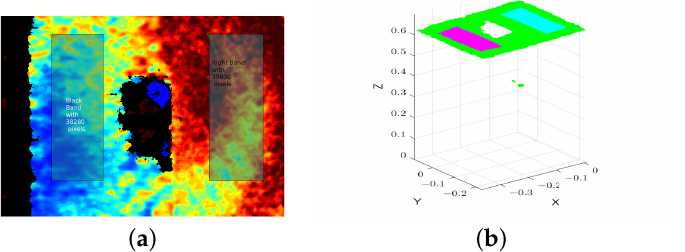
Figure 13. Example of a depth frame with segmented regions and respective point cloud with the segmented regions from the acquisition D415— empty . ( a ) Depth frame with segmented bands/regions. ( b ) Point cloud with segmented bands/regions. The left band is colored in magenta and the right band is colored in